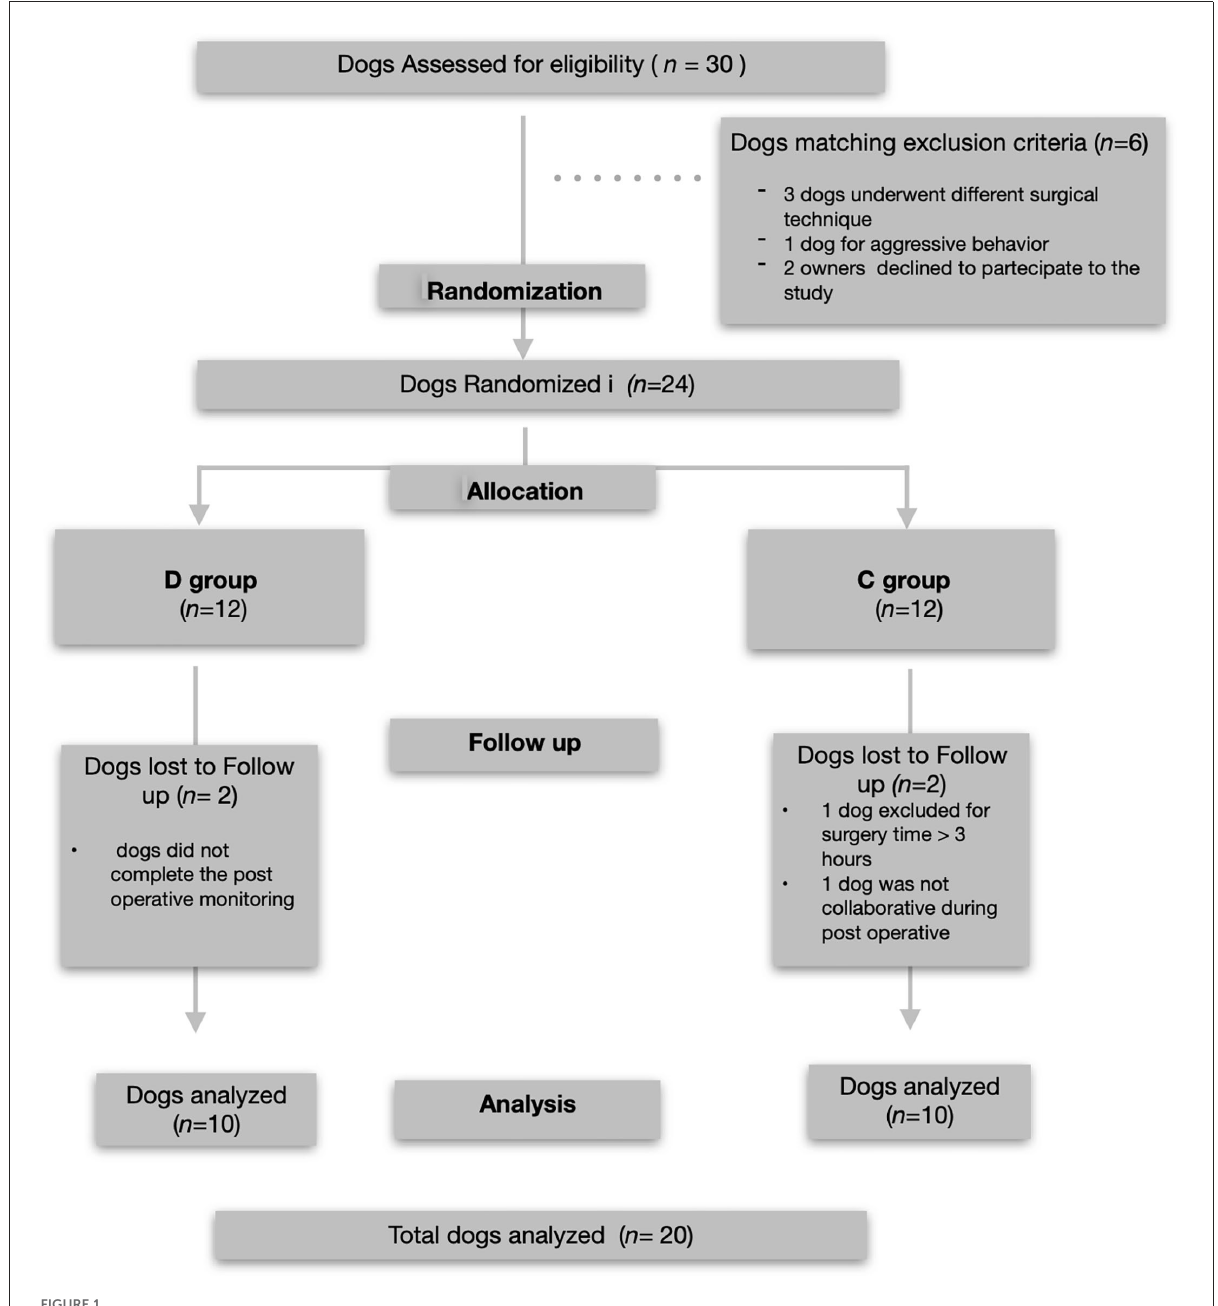
FIGURE1 Consolidated Standards of Reporting Studies Statement flow diagram of the enrollment and group